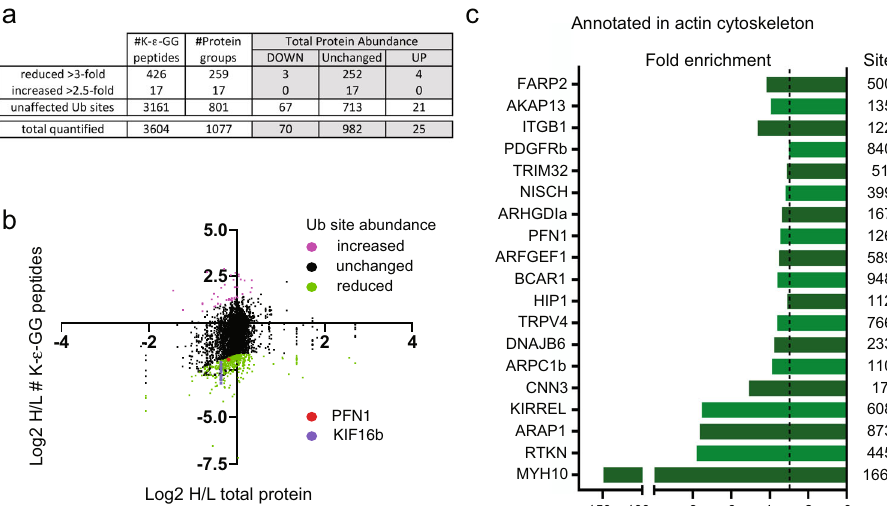
Fig. 3 Identi fi cation of putative NEDD4 targets. a Tabulated values for the number of ubiquitin (ub) remnant enriched peptides satisfying criteria of being affected by Nedd4 knockdown, the number of corresponding protein groups and a breakdown of abundance changes for proteins in either group. A breakdown of these values across the entire dataset (for all ubiquitin remnant peptides with cognate proteins in the pre-enrichment dataset) is shown on the last line. b 2D plot of log2 H/L ratios for all ubiquitin remnant enriched (K- ε -GG) peptides (y-axis) versus the log2 H/L ratio of their cognate protein (x-axis). Ubiquitin remnant enriched peptides with over 3-fold decrease compared to matched total protein are shown in green. Ubiquitin remnant peptides over 3-fold increase compared to matched total protein are shown in magenta. Ubiquitination events on PFN1 are shown in red, and KIF16B in purple. c Proteins with peptides containing over 3-fold reduced ubiquitination that are annotated in the actin cytoskeleton pathway. Only the top-ranked site for each protein is shown with corresponding lysine